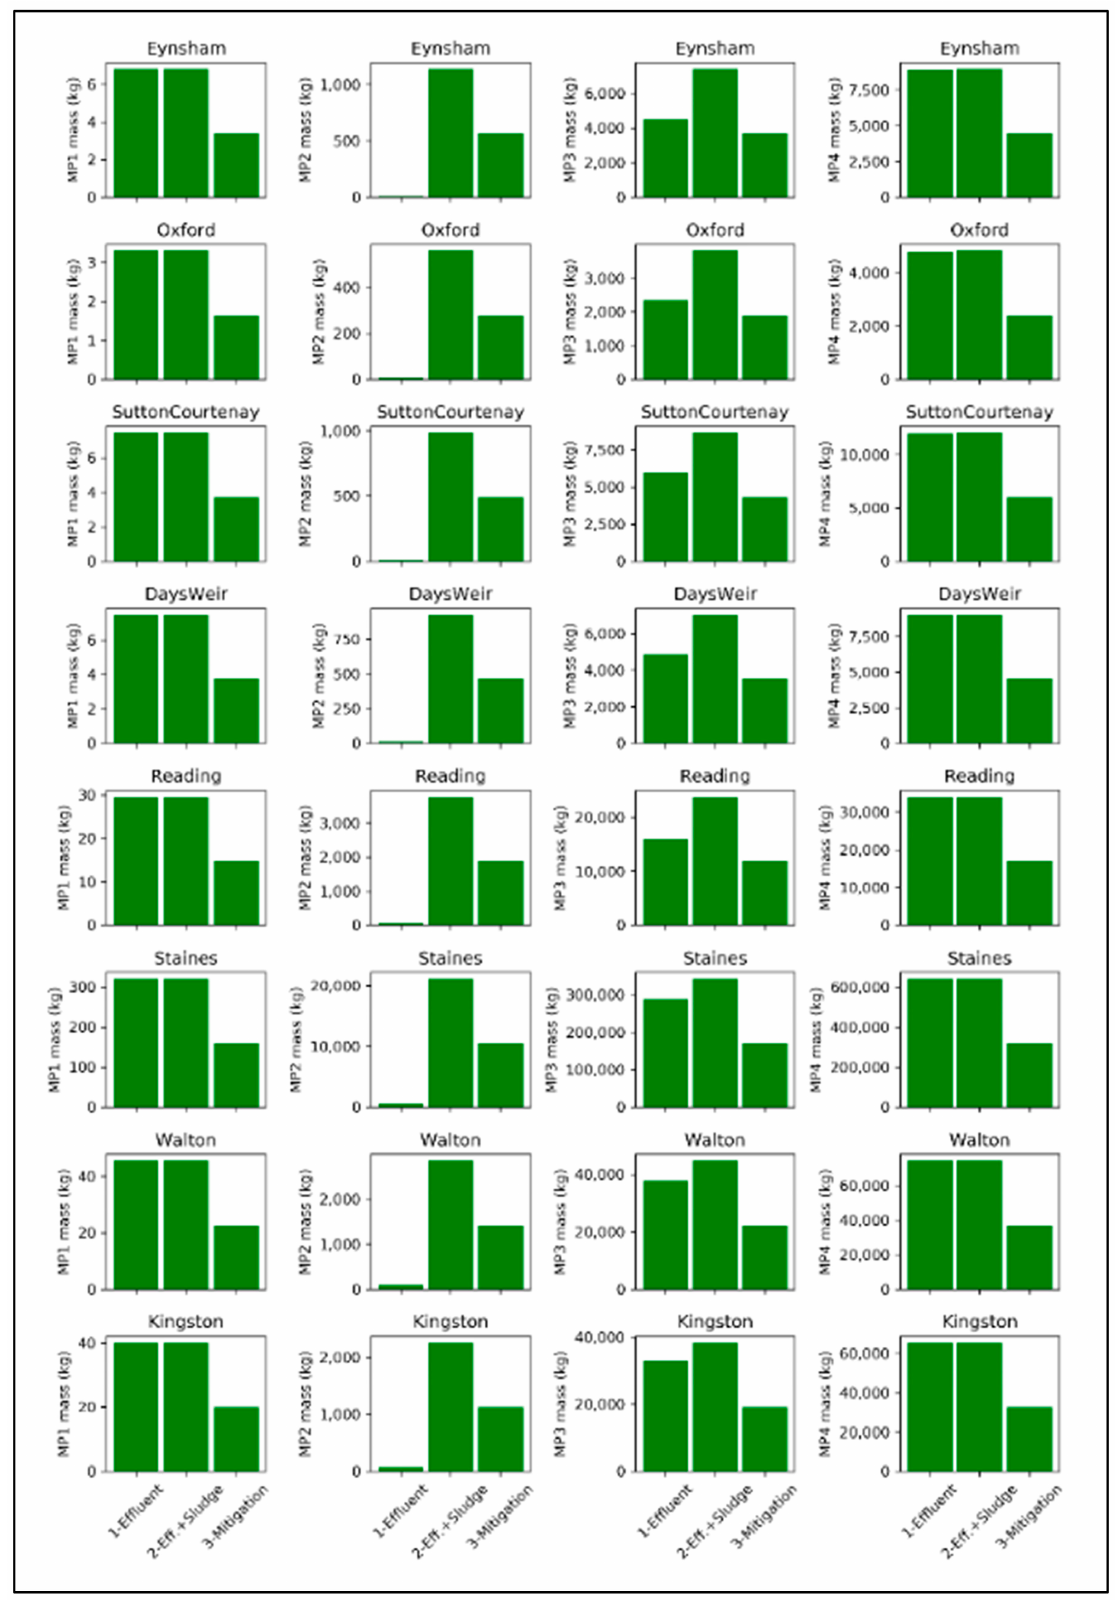
Figure 3. Comparison of the three scenarios in terms of average annual suspended mass load (kg/year) per microplastics class and per